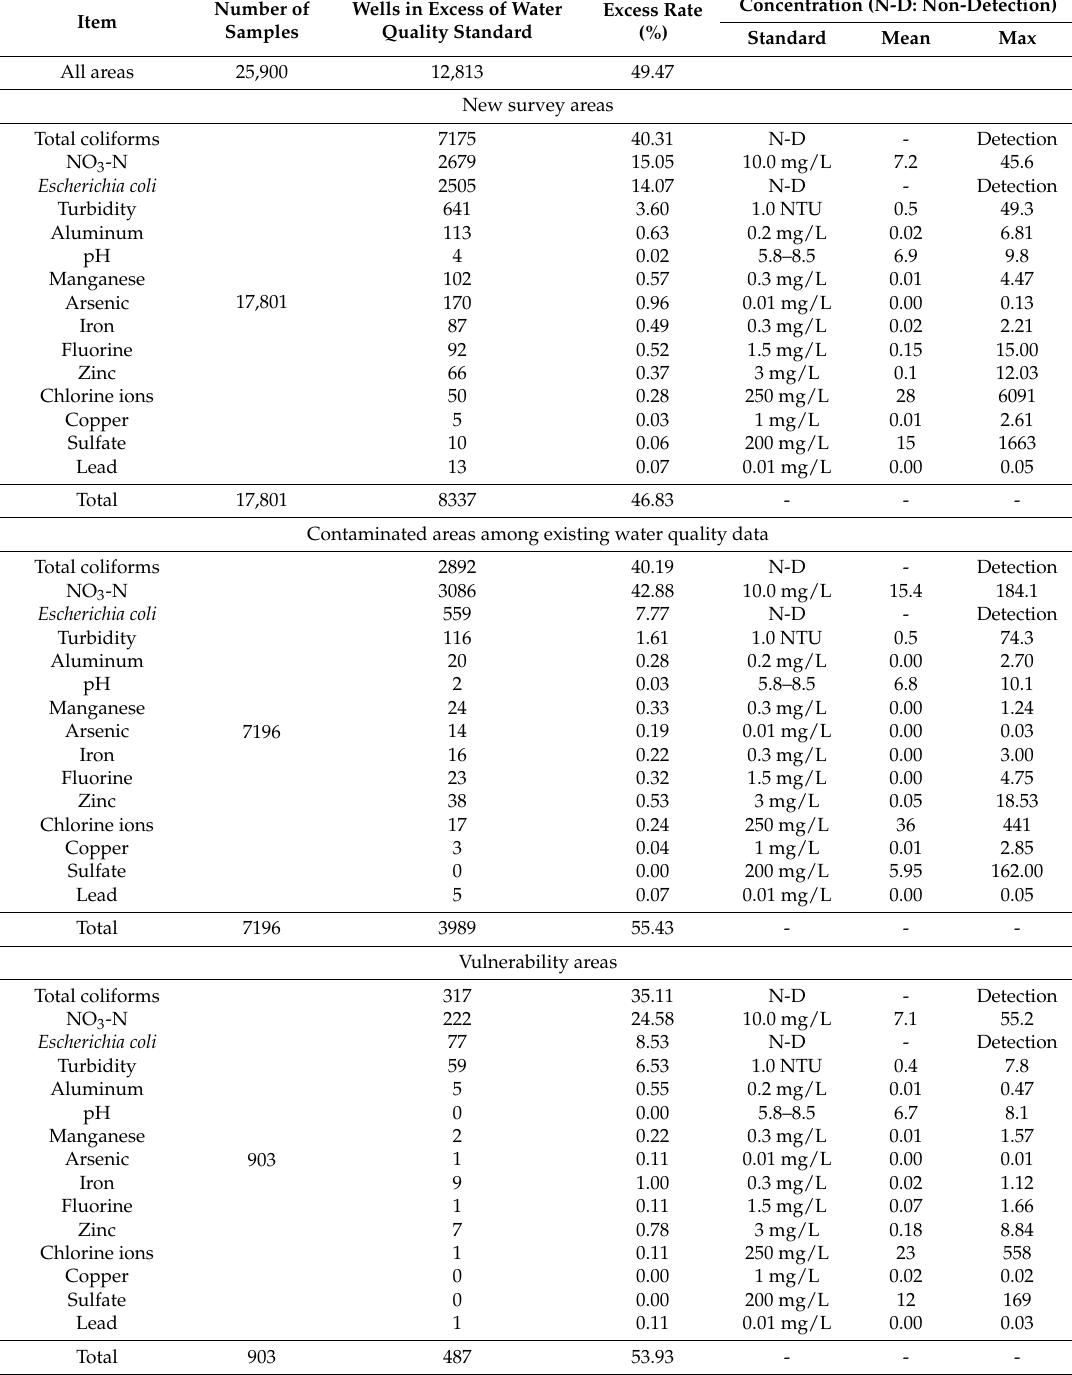
Table 8. Results of water quality analysis with 15 items in new survey areas in